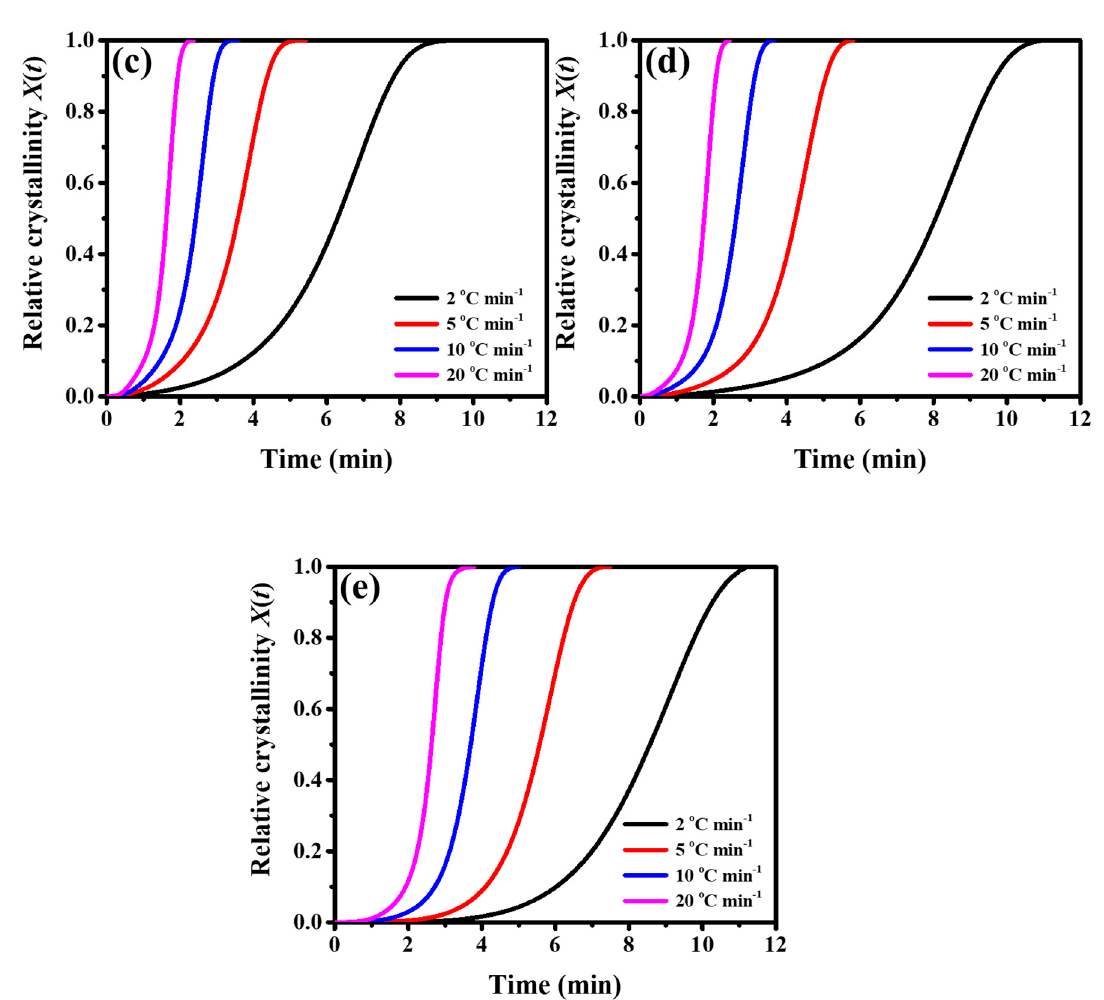
Figure 7. Relative crystallinity ( X ( t )) as a function of crystallization time at various temperatures for PBT- co -PTMEG copolymers at different contents of PTMEG. For synthesized copolymer, ( a ) PBT, ( b ) PBT- co -PTMEG-10, ( c ) PBT- co -PTMEG-20, ( d ) PBT- co -PTMEG-30, and ( e ) PBT- co -PTMEG-40 at various cooling rates. The solid lines represent the DSC experimental results of the Avrami equation.